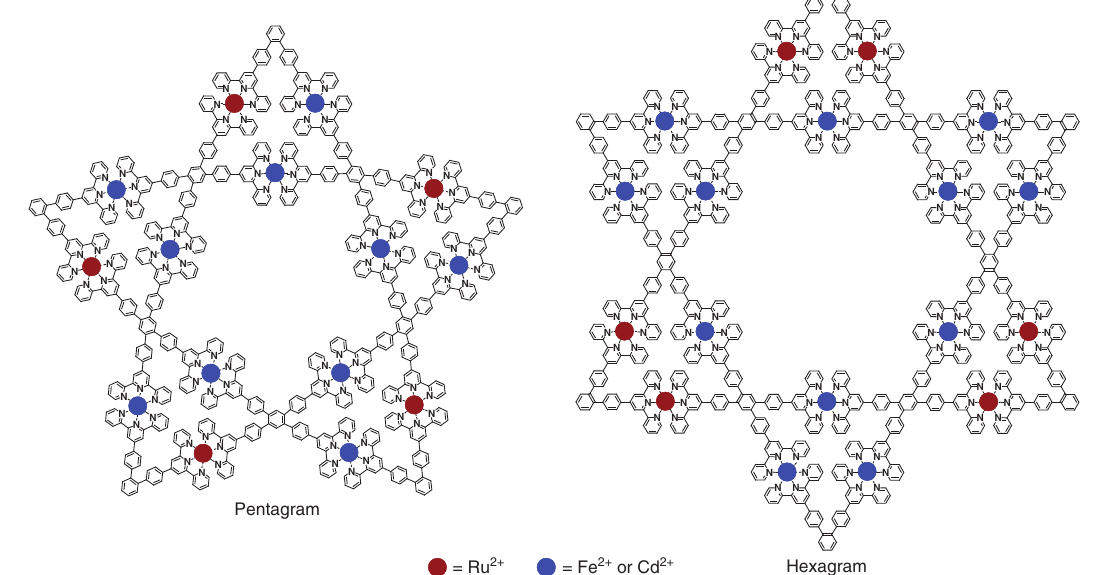
Figure 1 | Chemical structures of supramolecular pentagram and hexagram. Star-shaped pentagram and hexagram contained five or six 1,2-bisterpyridines, five or six 1,2,4,5-tetraterpyridines and fifteen or eighteen metals, respectively. NATURE COMMUNICATIONS|8:15476|DOI: